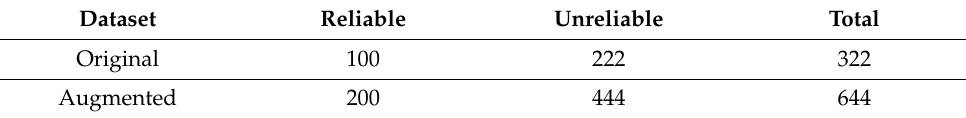
Table 4. Class frequency of original and augmented data of Arabic fake